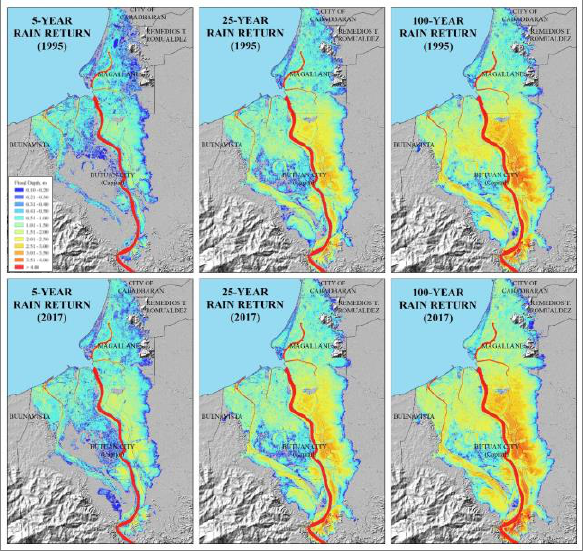
Table 7. Total simulated discharge at Dankias Station (in Million Figure 4. Flood depth maps generated for the 1995 and 2017 land cover conditions under three extreme rainfall m 3 )